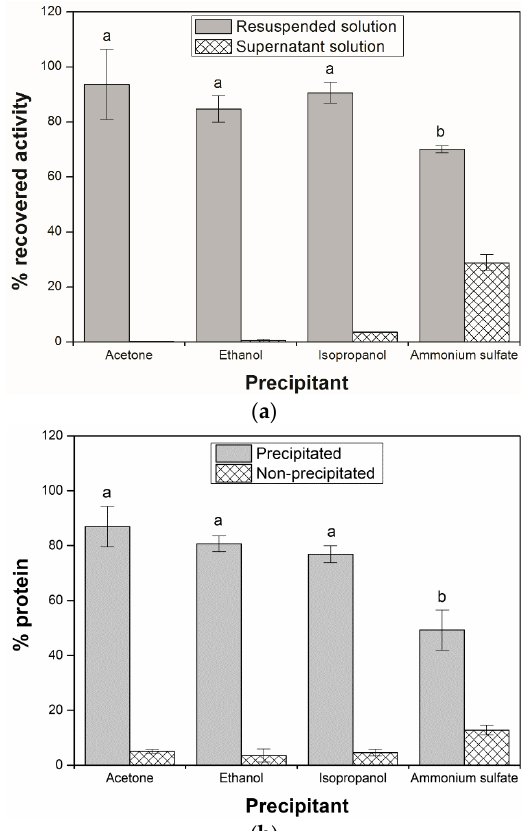
Figure 3. Screen of precipitants for amyloglucosidase (AMG 300L), the percentage of recovered activity ( a ) and the percentage of precipitated protein ( b ). Precipitation conditions: precipitant/enzyme solution volume ratio of 9:1, at 4 °C, 60 min precipitation under 150 rpm shaking, and enzyme solution prepared in 50 mM sodium citrate buffer pH 4.5. Note: Values are shown as the mean of triplicate measurements ± s.d. Means followed by the same letter are not statistically different by Tukey’s test ( p < 0.05). Percentage of protein was calculated taken the initial protein as